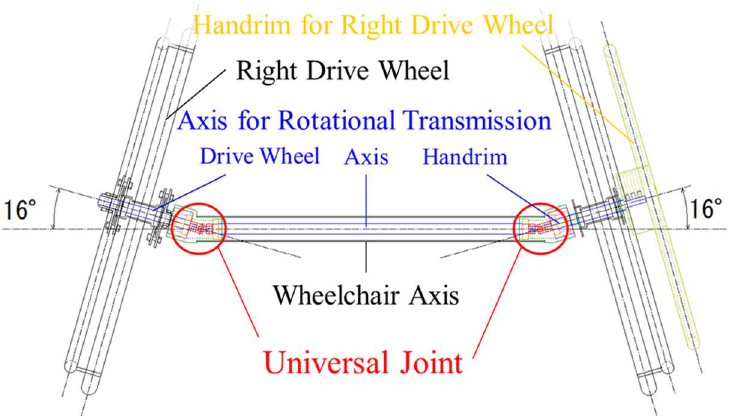
Figure 1. The mechanism to drive a wheel-chair straight by one-hand operation. This figure is in condition of seeing a wheelchair from back.